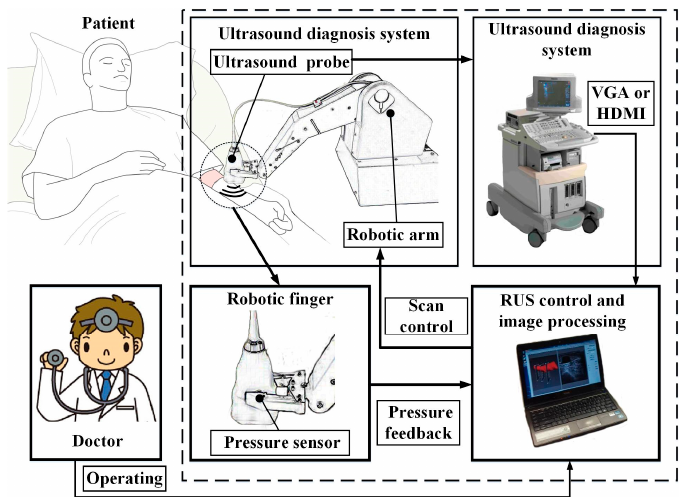
Figure 1. Schematic diagram of the robotic ultrasound system (RUS).